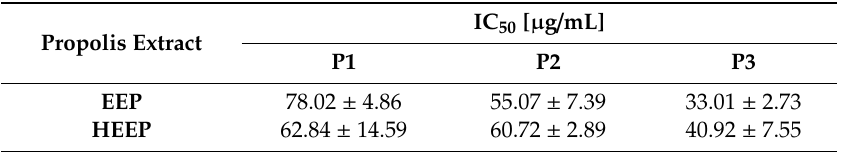
Table 3. The concentration of extracts that inhibits the formation of DPPH free radicals by 50% (IC 50